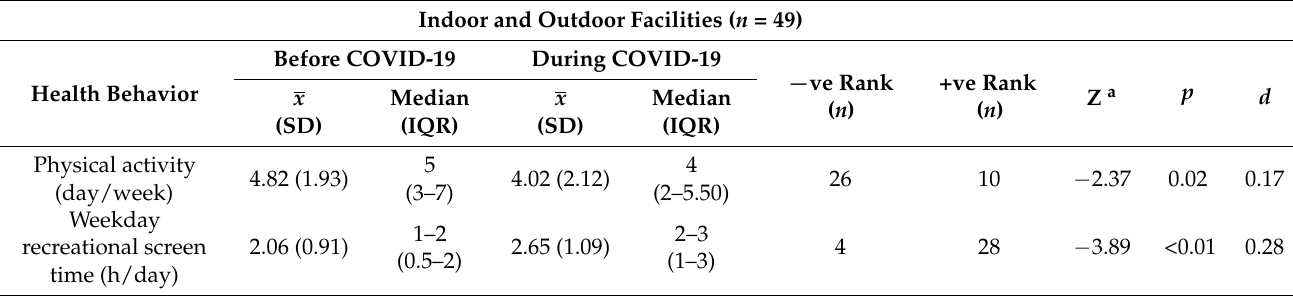
Table 5. Facility use differences in children’s physical activity and screen time from before to during COVID-19. Indoor and Outdoor Facilities ( n =